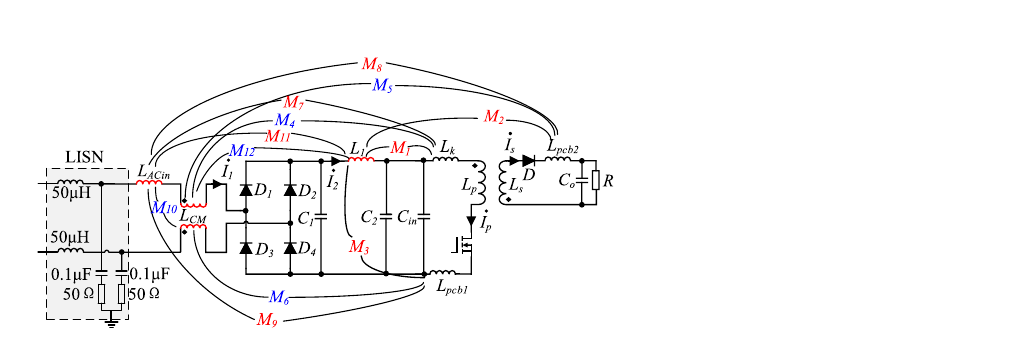
Figure 6. Complete near-field coupling model of the PD